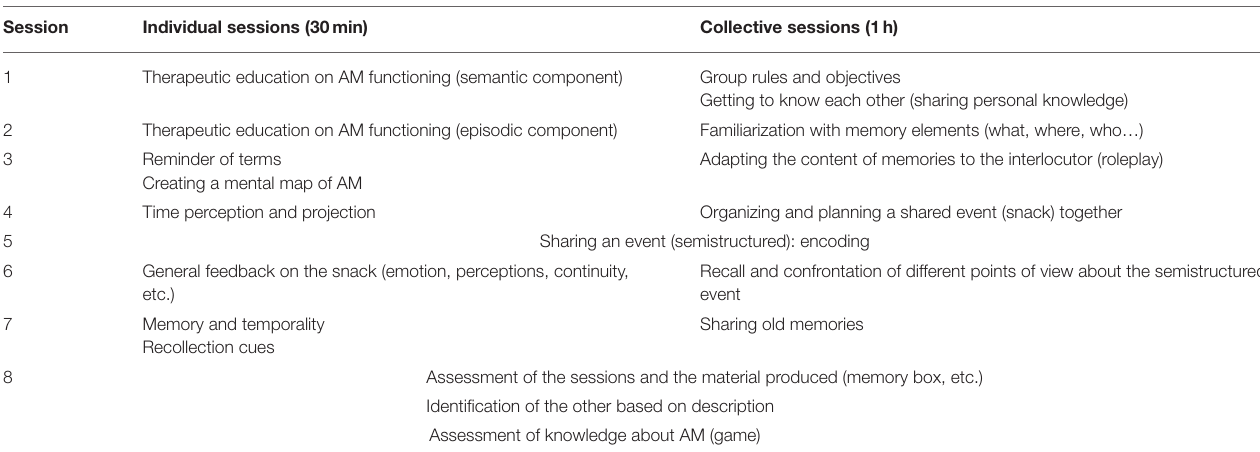
TABLE 4 | Content of each